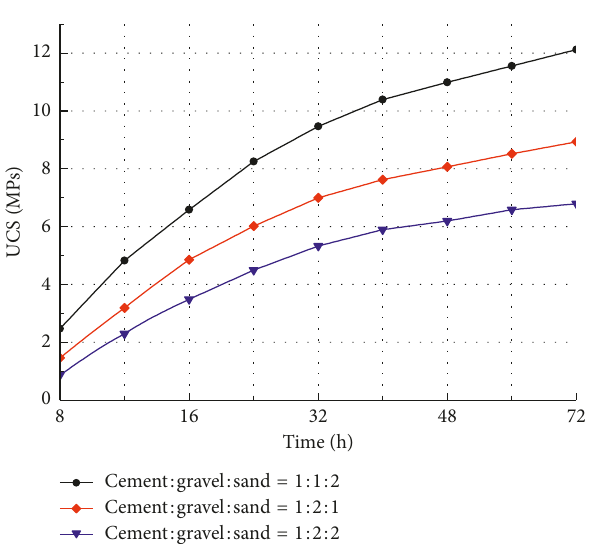
Figure 7: Compressive strength of the concrete under different